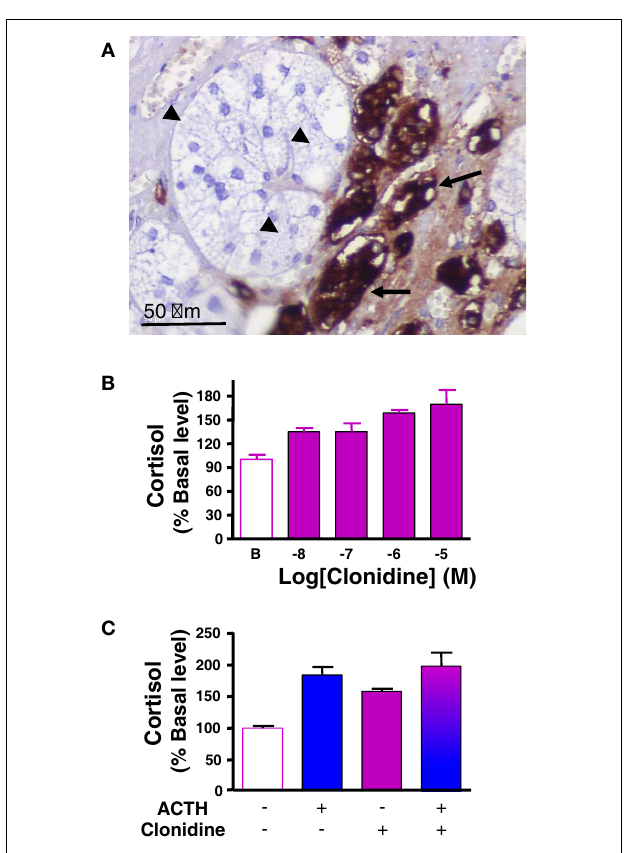
adrenal hyperplasia (BMAH) associated with Cushing’s syndrome . (A) Chromogranin A-positive chromaffin cells (arrows), which represent the main source of catecholamines in the normal adrenal gland, were in close contact with steroidogenic cells (arrow heads) in BMAH tissue. (B) Clonidine, an α 2 receptor agonist, dose-dependently stimulated cortisol secretion by cultured adrenocortical cells derived from a BMAH tissue. Adapted from Ref. (47). (C) The maximum cortisol responses of cultured BMAH adrenocortical cells to high concentrations of ACTH (10 − 10 M) and clonidine (10 − 6 M) were not additive, suggesting that α 2 and MC2R receptors are coupled to a common transduction